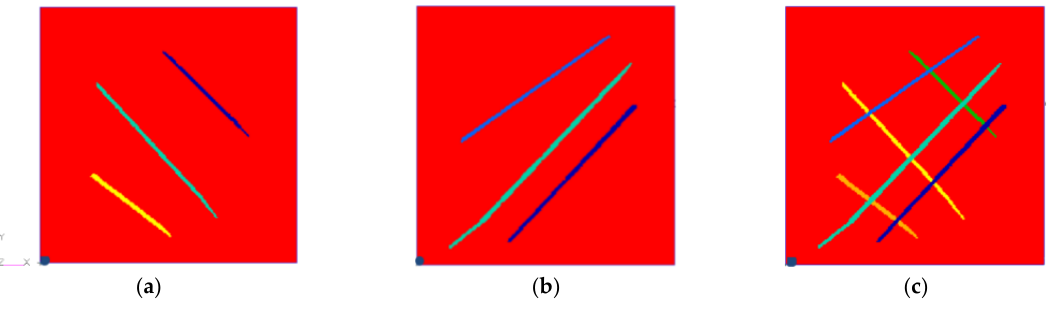
Figure 11. ( a ) Fractures perpendicular to the flow direction; ( b ) Fractures parallel to the flow direction; ( c ) Mixed fracture orientations. The blue points represent the wellbores. Figure 12 indicates that the orientation of fractures near the wellbore plays a key role in the formation ’s conductivity. When the fractures were perpendicular to the flow direc- tion, the derivative gradually decreased after the early time period and then had an up- ward trend. When the fracture parallel to the flow direction dominated the whole flow in the formation, the derivative of bottom-hole pressure decreased with two plateaus. This feature is usually regarded as the typical identification character of multilayers in pressure transient testing interpretation. The reason it also appears in fracture networks could be explained by analyzing the velocity profiles. As shown in Figure 13a, when the fracture orientation was perpendicular to the flow direction, the velocities in the three fractures